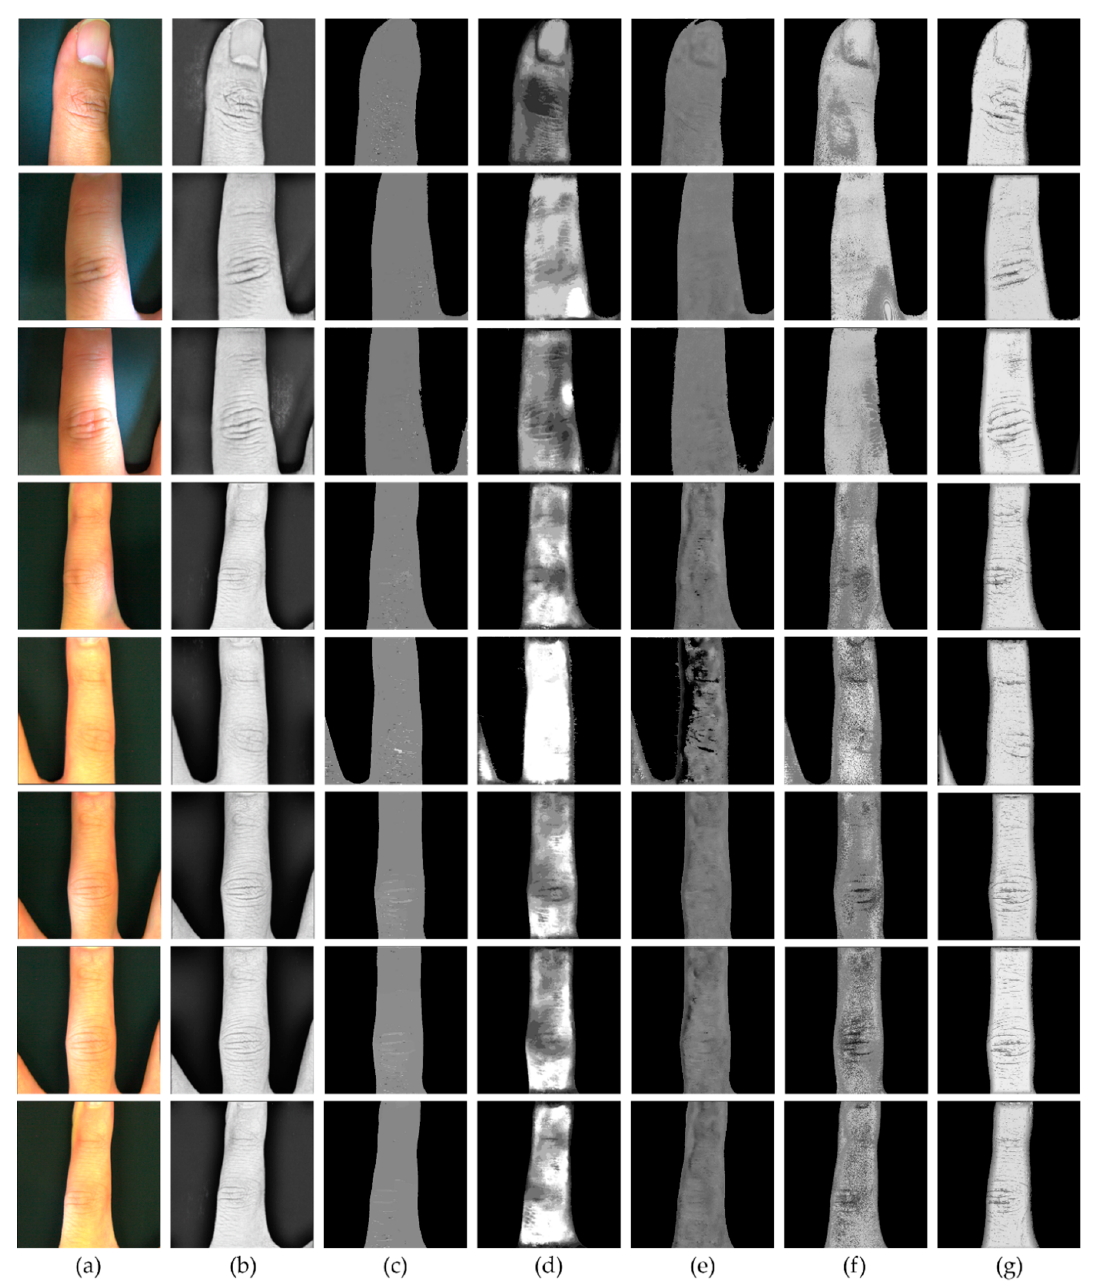
Figure 11. The qualitative comparison results with state-of-the-art depth estimation methods: ( a ) center view images taken with directional illumination; ( b ) the illumination-insensitive and texture-enhanced images obtained from proposed method; ( c , d ) shows estimated disparity maps from ( c ) Wang [23]; ( d ) Jeon [18]; ( e ) Zhang [26]; ( f ) Williem [20]; ( g ) our method.